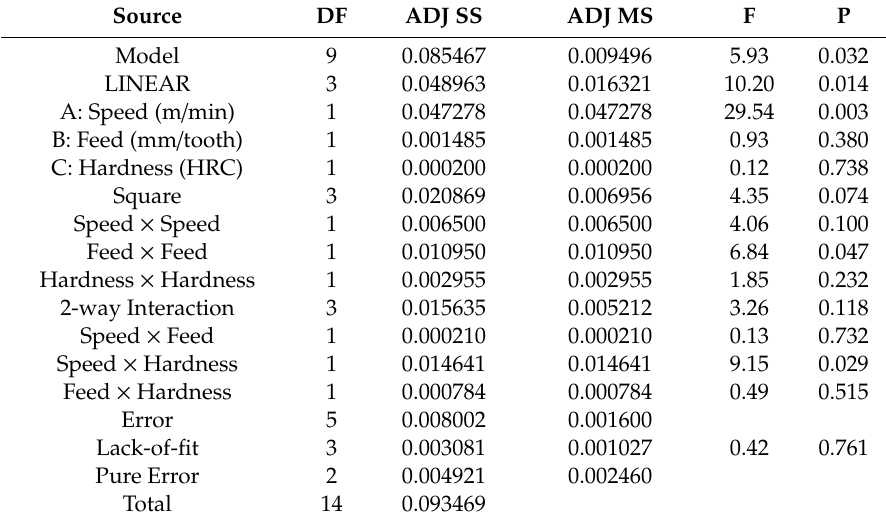
Table 5. Analysis of variance (ANOVA) for the lowest surface roughness.